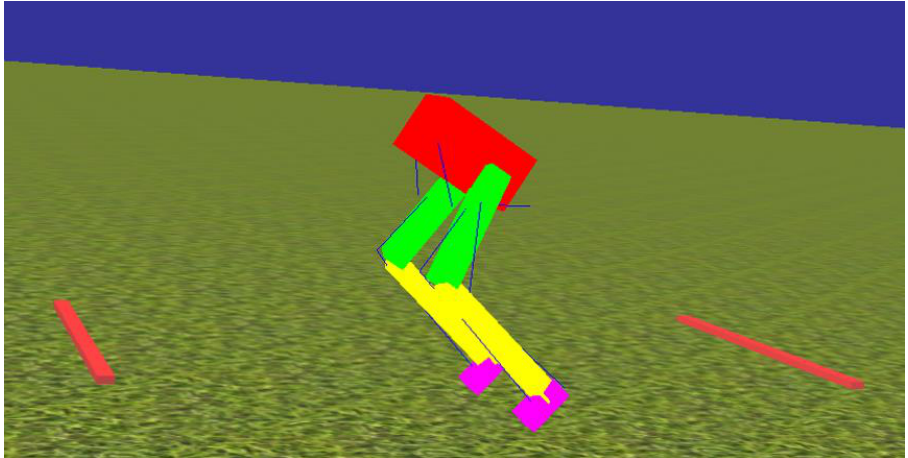
Figure 3. Biomechanical model of a rat hindlimb. Motion is constrained in the sagittal plane with hinge joints. The two bars on the ground support the body.